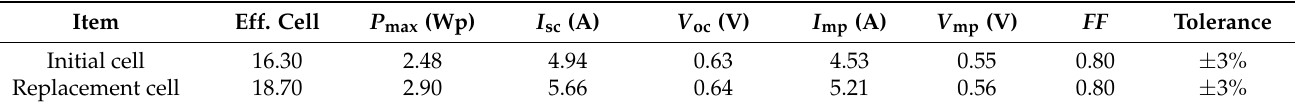
Table 3. Electrical characteristic deviation of the initial and replacement cells.